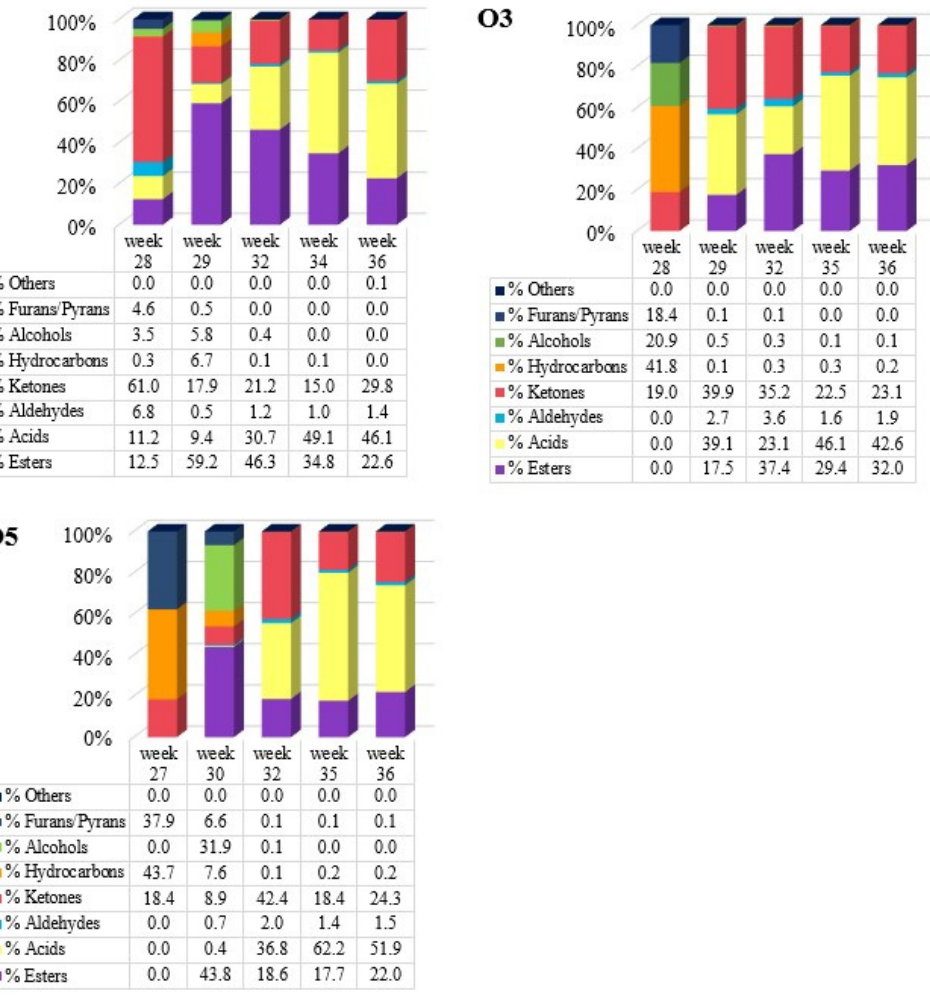
Figure 3. Chemical composition (%) of VOCs per orchard and per examined week.